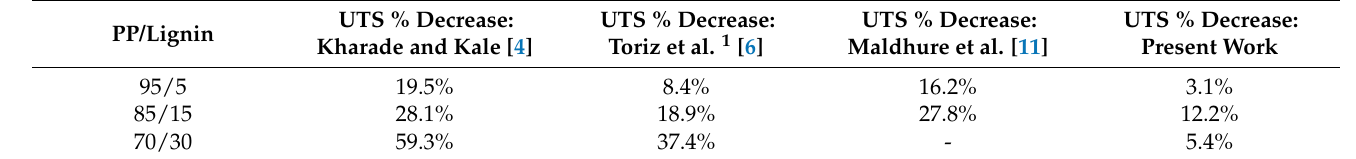
Table 5. Comparison of Ultimate Tensile Strength of PP-lignin with literature.